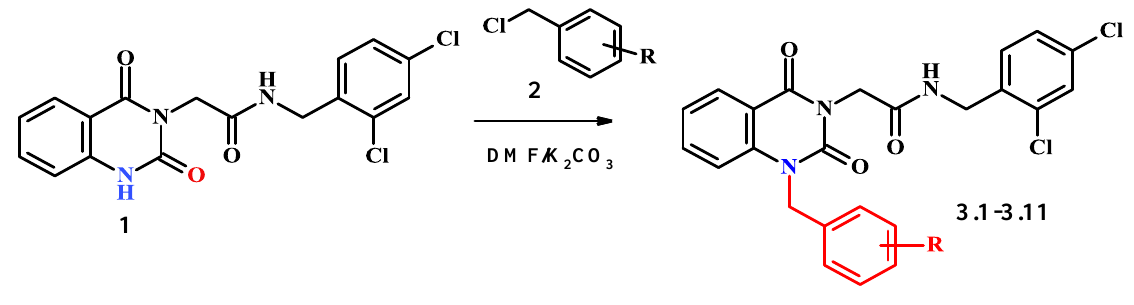
Fig. 4. The synthesis of N-[(2,4-dichlorophenyl)methyl]-2-(1-(R-benzyl)-2,4-dioxo-quinazolin-3-yl)acetamide All corresponding proton signals were present in the 1 H NMR spectra (Table 2). When compared with the spec- trum of the original acetamide 1 [15], the appearance of benzyl radical protons – methylene group signal in singular form at 5.55-5.25 ppm, as well as additional aromatic protons appearance, and the absent signal of NHCO group of quinazoline cycle at 11.5 ppm were specific for the spectra of all synthesized compounds 3.1-3.11 . The large number of aromatic protons in the structure of 3.1-3.11 compounds led to their signals overlaying, which complicated their inter- pretation with reference to the allocation in the cycle, but their number was fully consistent with the structure of com- pounds. The proton signal of the NHCO benzylamide residue group resonated in the triplet form at δ 8.82-9.72 ppm, and the methylene group – in the doublet form at 4.35-4.33 ppm. Protons of the methylene CH CO group of 3.1-3.11 2 compounds were detected as singles in 4.71-4.68 ppm range. Signals of methoxy and methyl groups in 3.3, 3.4 and 3.9, 3.10 compounds, respectively, were also